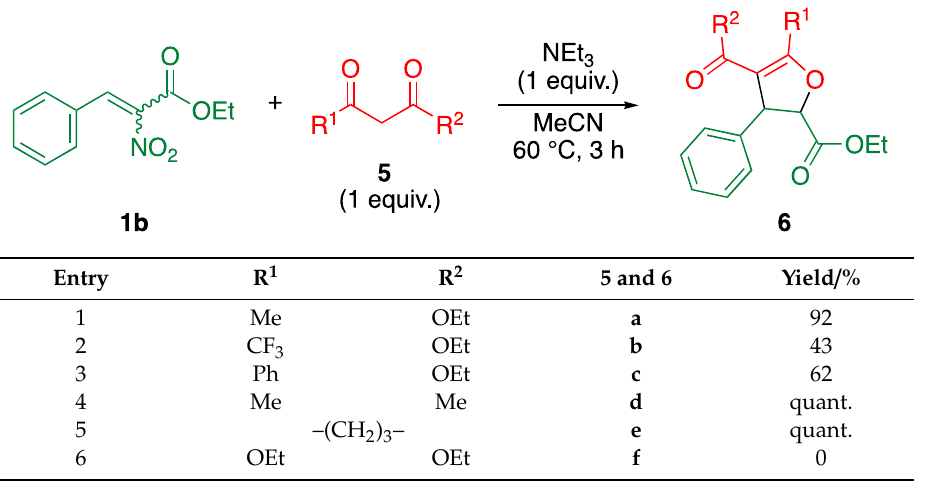
Table 1. Synthesis of functionalized 2,3-dihydrofuran 6 .